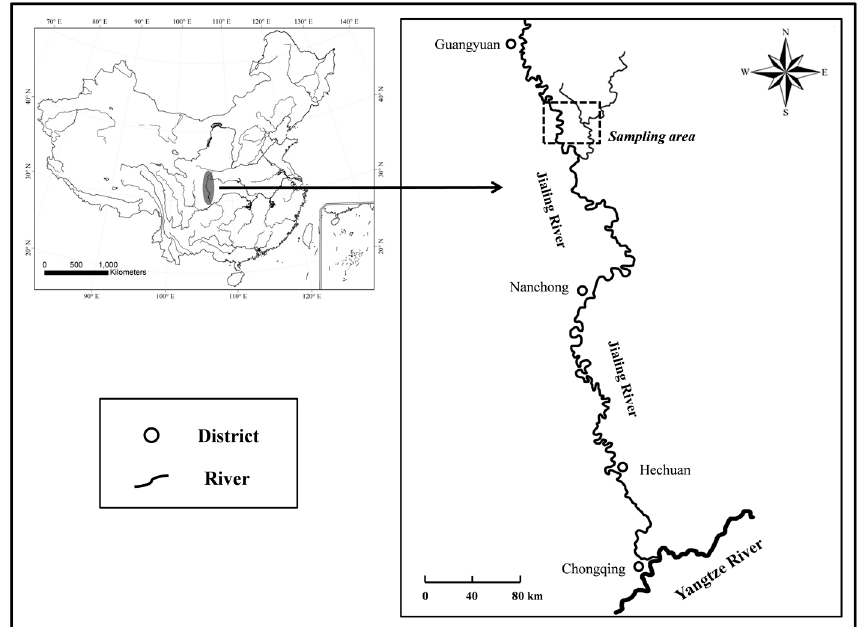
Figure 1. Map of study region in the Jialing River, the shaded part represents the Jialing River basin, the dotted region is the sampling area in the midstream of the Jialing River.